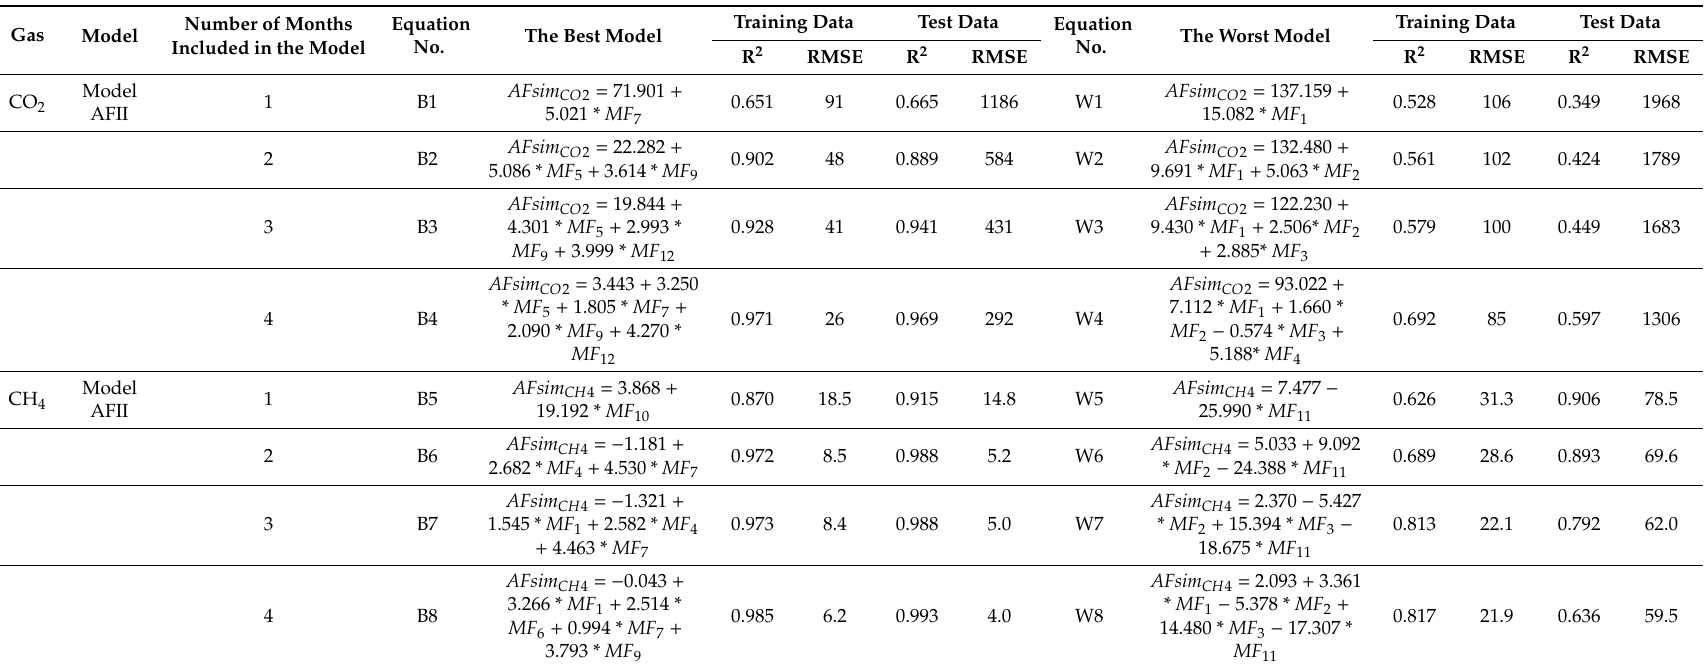
Table 3. The best (RMSE minimum) and worst (RMSE maximum) AF CO 2 and AF CH 4 estimating equations using data from 1 to 4 months. Remaining equations are shown in Tables S2 and S4. To provide more information on equations performance, the corresponding R 2 and RMSE values of training data are also reported. AFsim (g m − 2 yr − 1 ) is the simulated annual cumulative flux; MFn (g m − 2 month − 1 ) indicates the observed monthly flux of di ff erent months, for example, MF 7 represents the monthly flux of July and MF 5 represents the monthly flux of